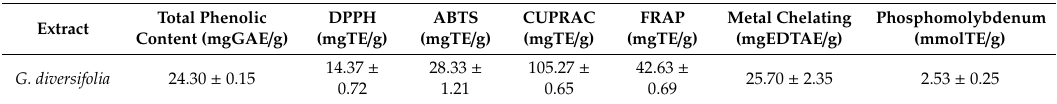
Table 5. Results of in vitro antioxidant assays on G. diversifolia methanolic extract. Values are reported as mean ± SD of three parallel experiments. GAE: Gallic acid equivalent; RE: Rutin equivalent; TE: Trolox equivalent; EDTAE: EDTA equivalent; na: not active. Total Phenolic DPPH ABTS Extract Content (mgGAE / g) (mgTE / g) (mgTE / g)